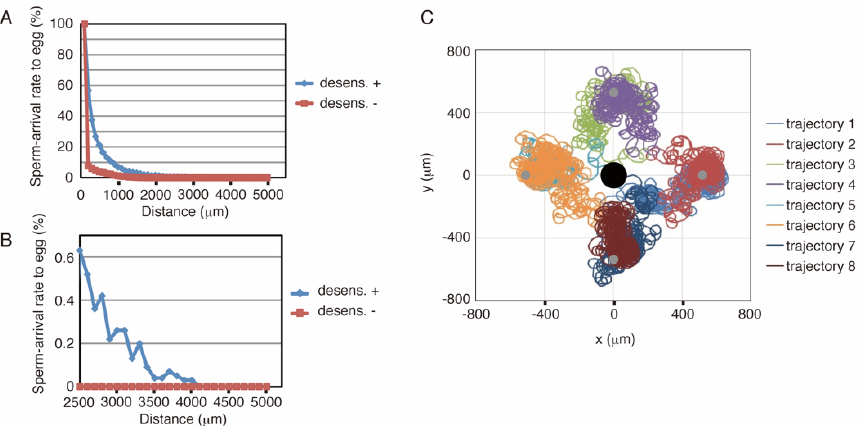
Figure 2. Results of simulations with the sea urchin model. ( A ) Summary of simulation results. The x -axis indicates the distance between the sperm start-point and the center of the egg, and egg-arrival rates of sperm from these points are shown as the longitudinal axis ( n = 10,000). The blue symbols represent the results of the desensitization model, and the red symbols represent the results of a model in which the desensitization function is frozen. The length of the simulation was 30 min. ( B ) Magnification of a part of A. ( C ) Representative trajectories in the simulation. The black circle at the center indicates the egg, and the sperm started swimming from the four gray circles. Trajectories 1 and 2, 3 and 4, 5 and 6, and 7 and 8 start from the same points. Trajectories 2, 4, 6, and 8 show successful examples, whereas the others represent failures.